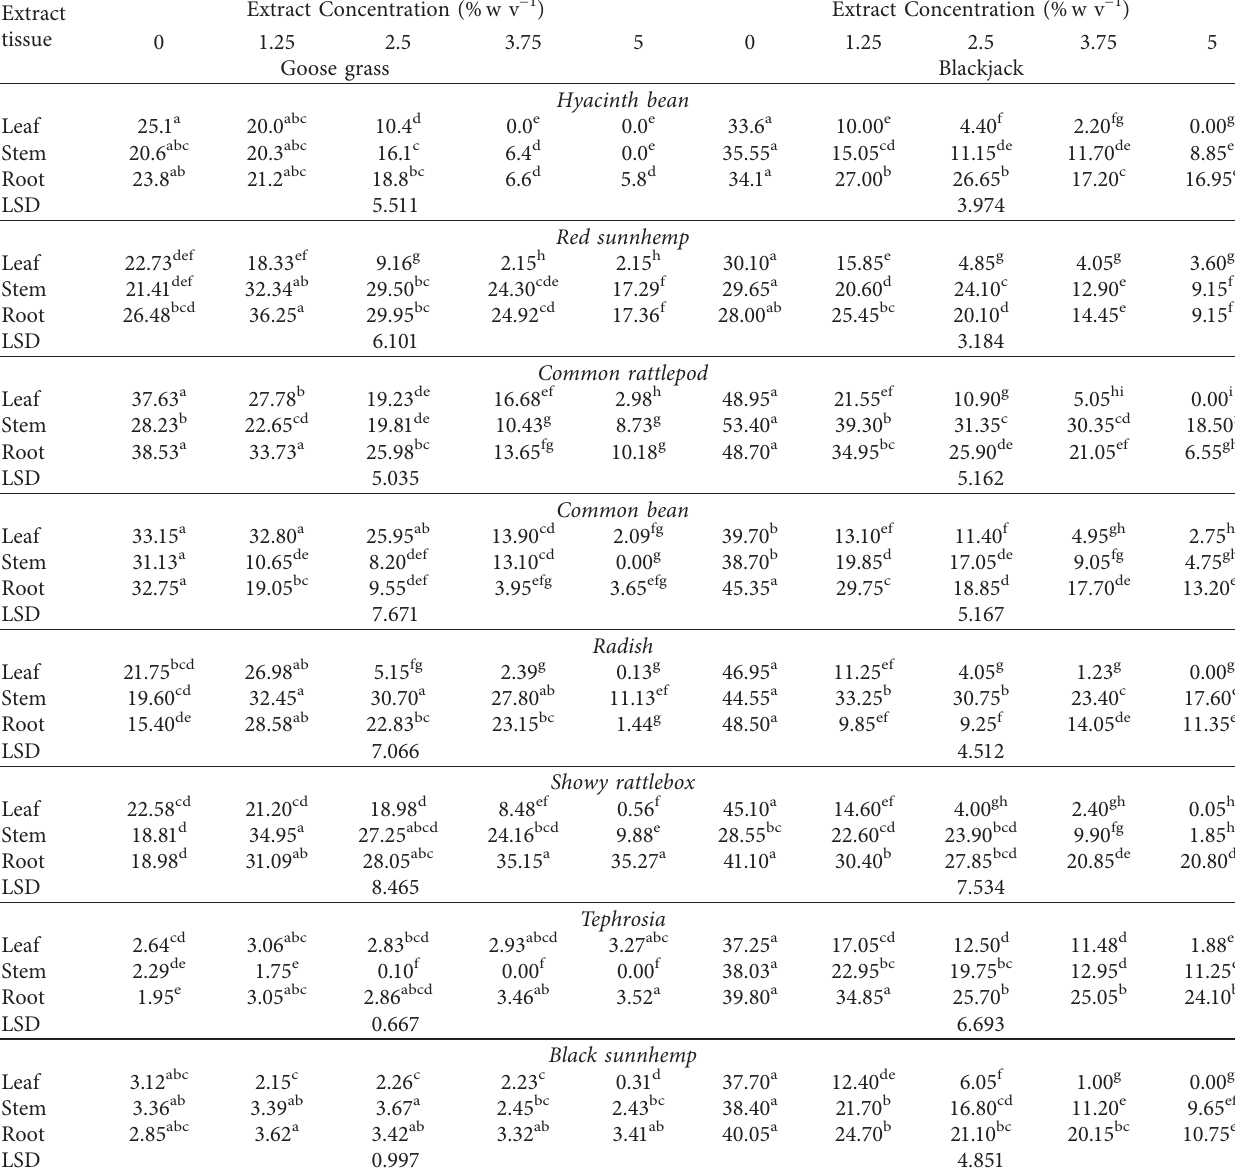
Table 4: Effect of aqueous extracts of eight green manure cover crops on the radicle length of goose grass and blackjack. Extract